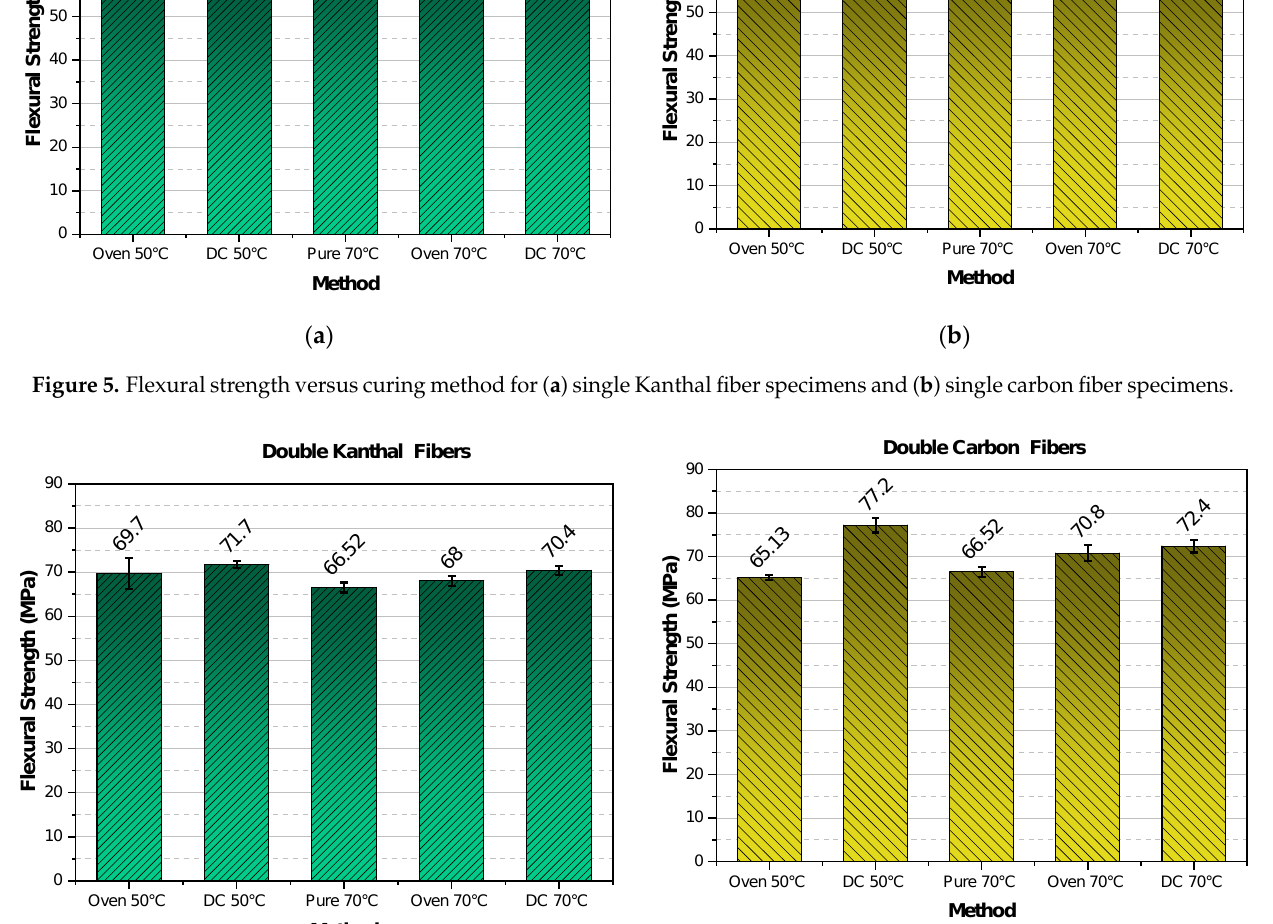
Figure 6. Flexural strength versus curing method for ( a ) double Kanthal fiber specimens and ( b ) double carbon fiber specimens.